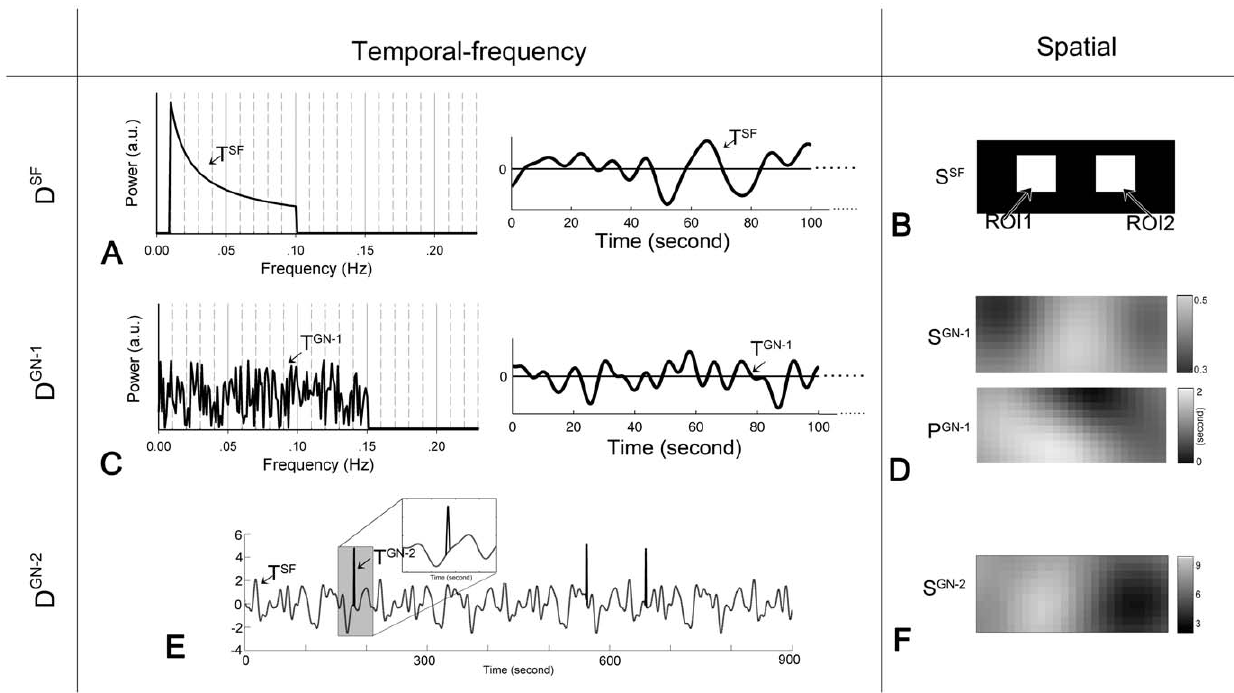
Figure 2. The simulated dataset. (A, C, E) Temporal-frequency characteristics of the simulated dataset. (B, D, F) Spatial characteristics of the simulated dataset. D GN { 1 denotes the spontaneous fluctuations, D GN { 1 the global noise 1 (i.e., the systemic physiological noises), and c ROI 1 { ROI 2 the global noise 2 (i.e., the motion artifact).